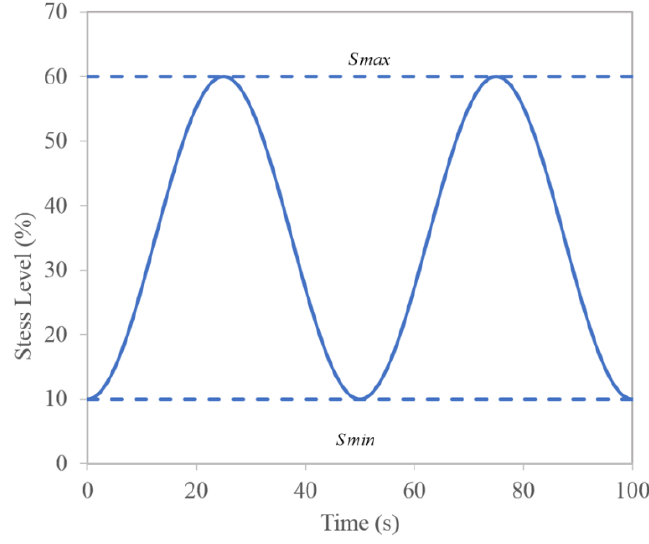
Figure 2. Loading diagram. Table 3. Experimental program of the concrete chloride ion erosion under the coupling condition of the cyclic load and dual salt.